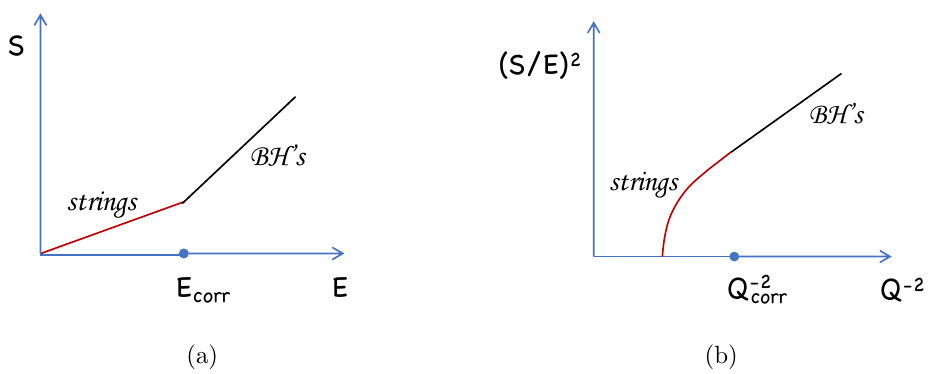
Figure 2. The string/black hole correspondence principle: (a) In (cid:13)at spacetime, the density of states is dominated by excited strings at low energies; above the correspondence point, black hole thermodynamics dominates. (b) In NS5 throats, black hole states are not normalizable if the slope Q of the linear dilaton (which governs the e(cid:11)ective string tension (cid:11) 0 strings govern the asymptotic density of